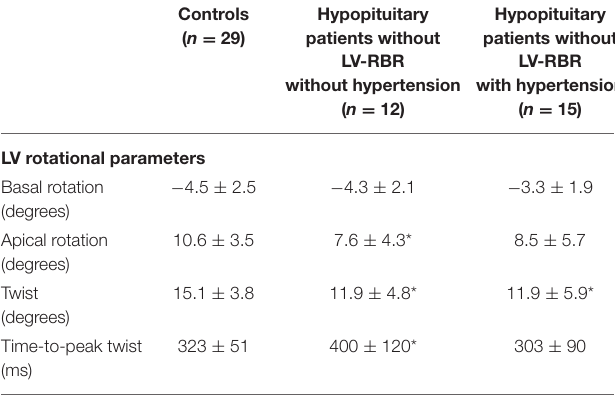
TABLE 4 | Comparison of three-dimensional speckle-tracking echocardiography-derived left ventricular rotational parameters between those of hypopituitary patients with hypertension or without hypertension and